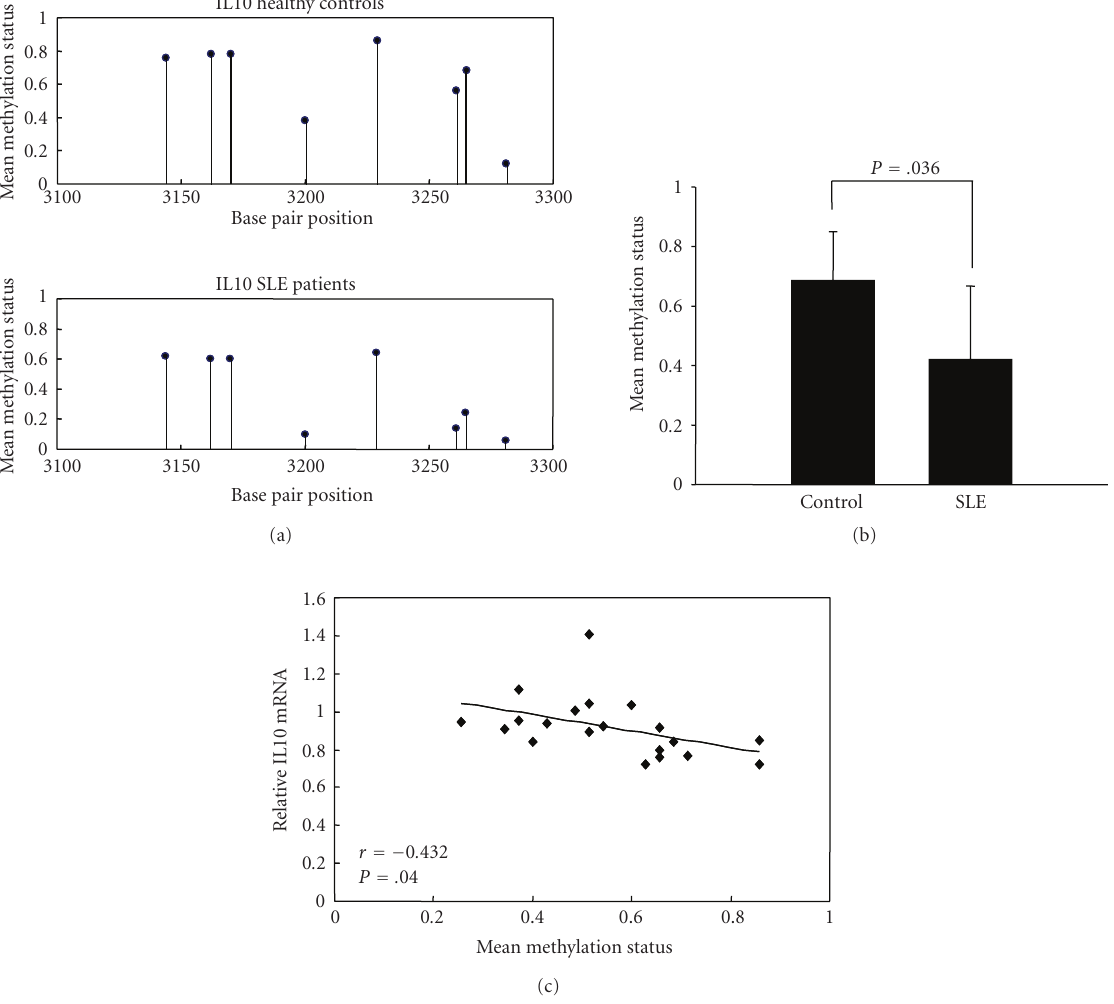
Figure 3: IL10 enhancer methylation patterns in CD4 + T cells from SLE patients and healthy controls. (a) The mean methylation status for each of the 8 CG pairs within intron 4 of the IL10 locus in CD4 + T cells from healthy controls ( n = 10; upper panel) and SLE patients ( n = 10; lower panel). (b) The combined average methylation status of 7 CG pairs (positions +3144, +3162, +3170, +3200, +3229, +3261, and +3265) in IL10 intron 4 in SLE CD4 + T cells was lower than healthy controls ( P = . 036). (c) Average IL10 promoter DNA methylation status correlated ( r = − 0 . 432) with relative mRNA level in SLE patients ( P = .